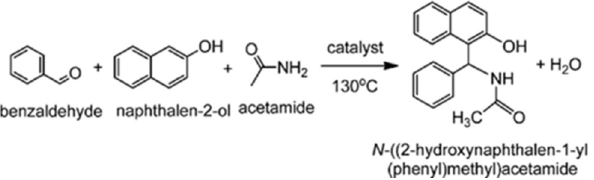
Figure 7. Condensation of benzaldehyde, 2-Naphthol, and acetamide. Reprinted with permission from [98]. Copyright (2012), American Chemical Society.